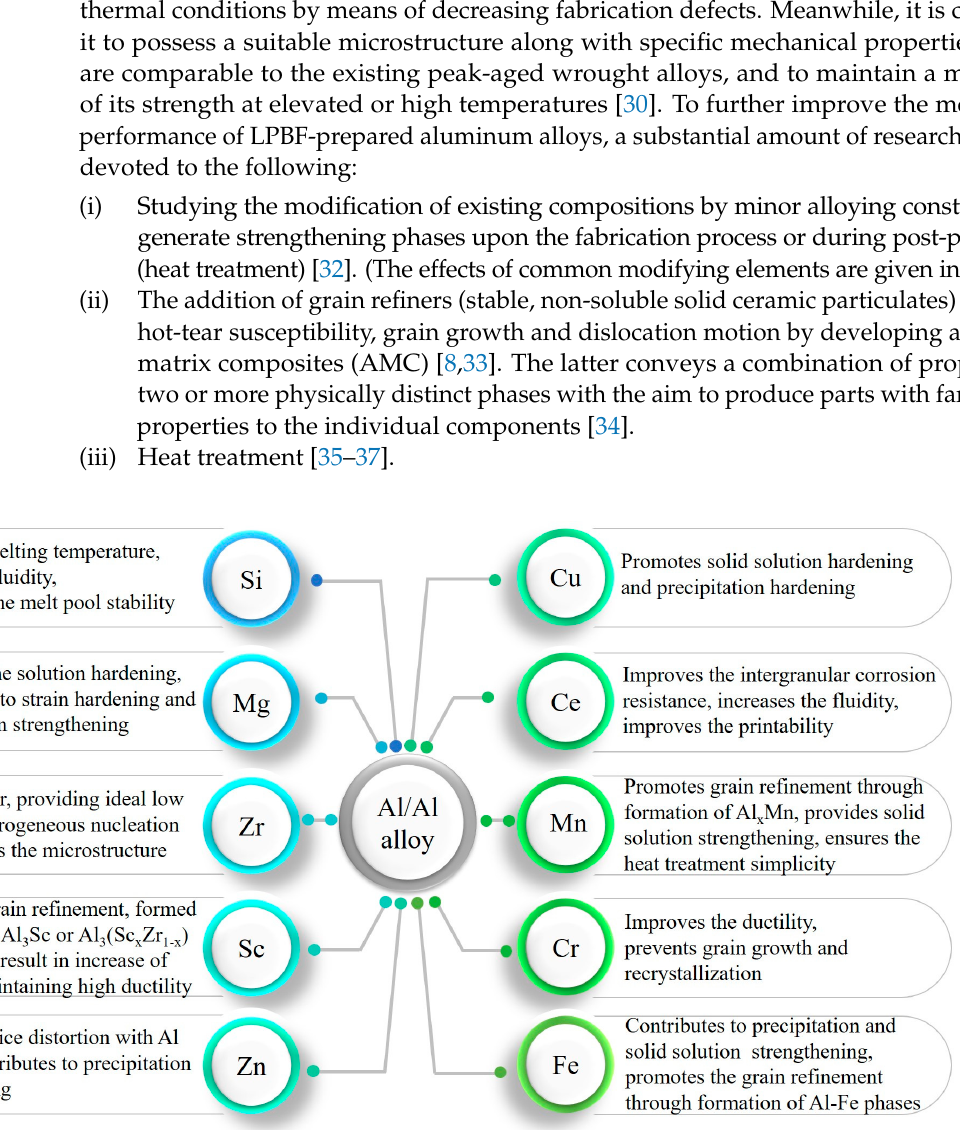
Figure 1. The influence of the main and modifying components on LPBF fabricated Al alloys